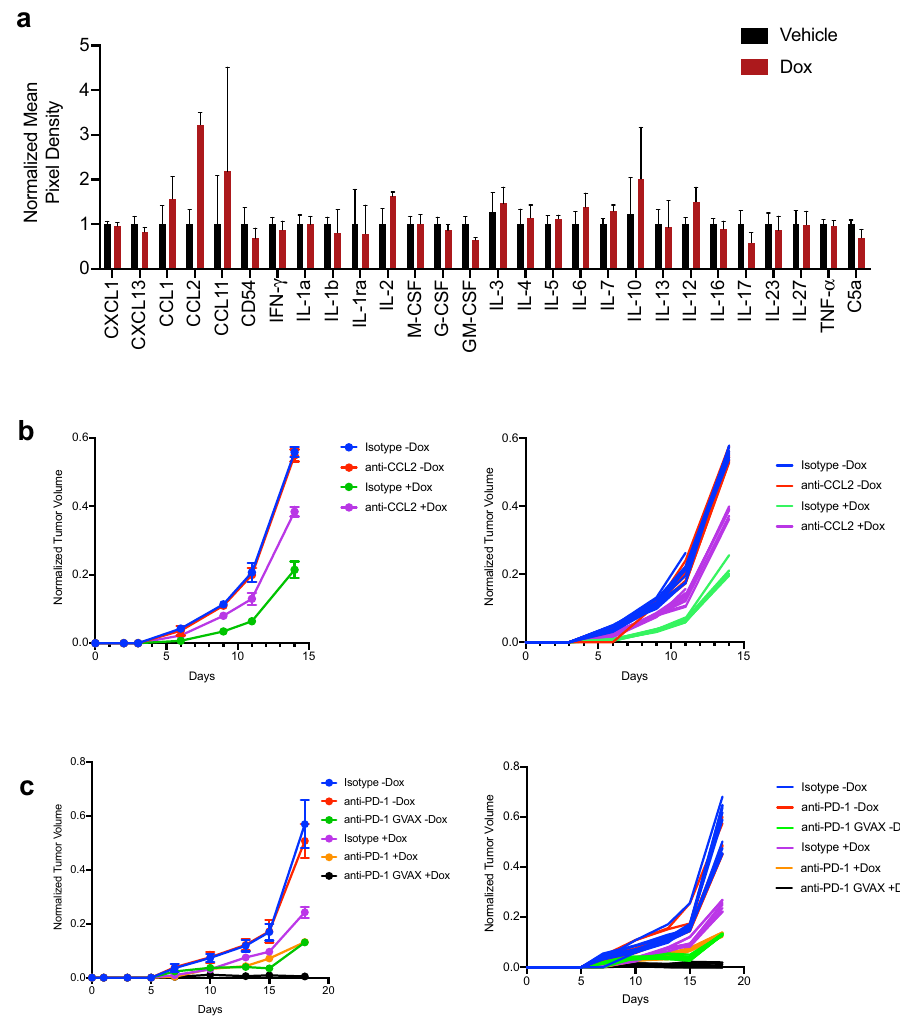
Fig. 5 Gata4 and anti-PD-1 immune checkpoint therapy combine to abrogate tumor growth. a Cytokine array of media harvested from KP lung tumor cells with dox-inducible Gata4 treated with vehicle (black) or dox (red). Data are mean ± SD and n = 4 for each group. b KP cells with dox-inducible Gata4 were transplanted into the fl anks of immunocompetent syngeneic hosts. Mice were treated with either isotype or anti-CCL2 antibody, with and without dox. Left panel shows aggregated tumor volume data by group with points representing mean ± SD and n = 10 per group combined from 2 independent experiments. Right panel shows individual tumor data with each line corresponding with an individual tumor. c B16 melanoma cells with dox-inducible Gata4 were transplanted into the fl anks of immunocompetent syngeneic hosts. Mice were treated with either isotype or anti-PD-1 antibody, with and without dox, and also GVAX, with and without dox. Left panel shows aggregated tumor volume data by the group with points representing mean ± SD and n = 10 per group combined from 2 independent experiments. Right panel shows individual tumor data with each line corresponding with an individual tumor. For this fi gure, source data are provided as a Source Data fi